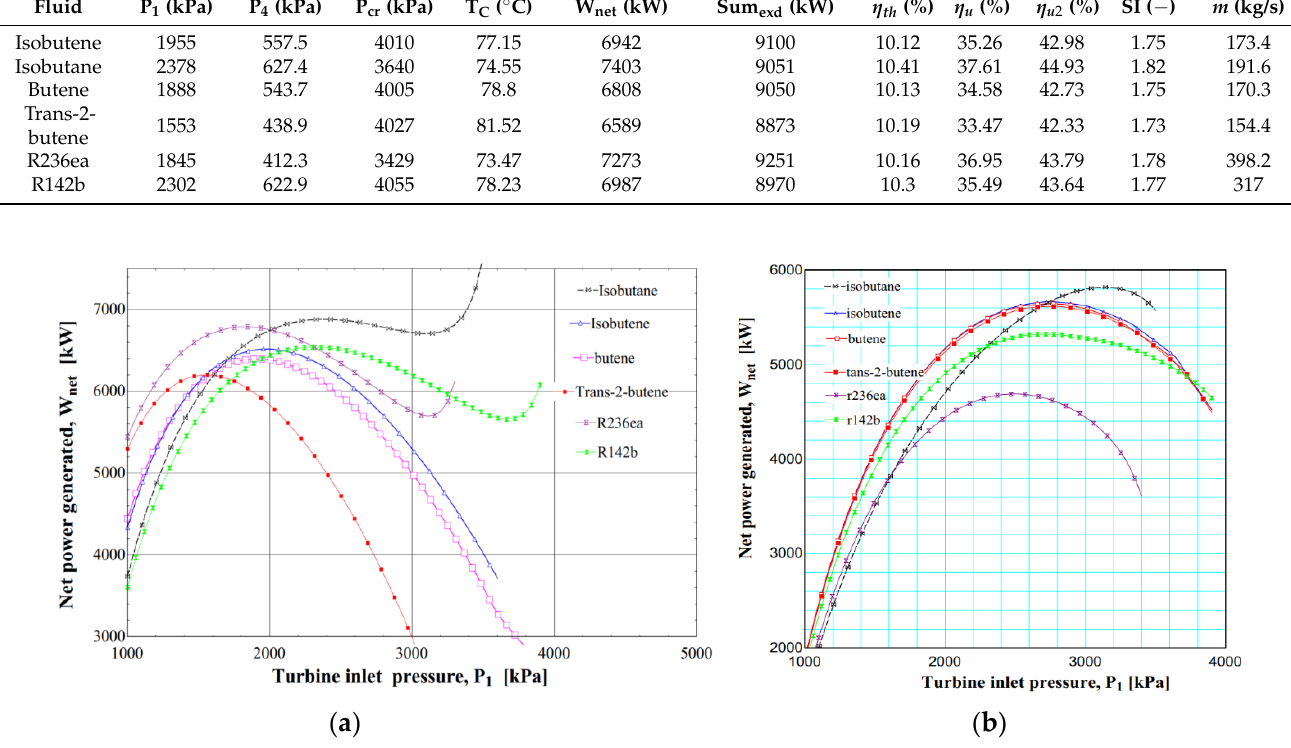
Figure 4. Turbine inlet pressure vs. the net power generated: ( a ) simple ORC, optimum pressures below 2000 kPa and ( b ) regenerative cycle with optimum turbine inlet pressures above 2000 kPa for the different fluids investigated.